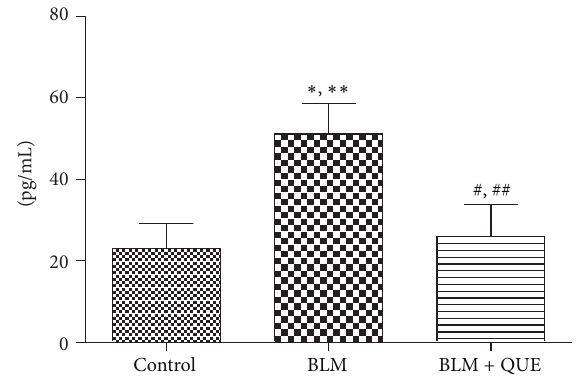
Figure 4: Plasma levels of tumor necrosis factor- 𝛼 on day 21 of treatment. 𝑛 = 10 . ∗ 𝑃 ≤ 0.05 , ∗∗ 𝑃 ≤ 0.01 versus control group. # 𝑃 ≤ 0.05 , ## 𝑃 ≤ 0.01 versus bleomycin group.